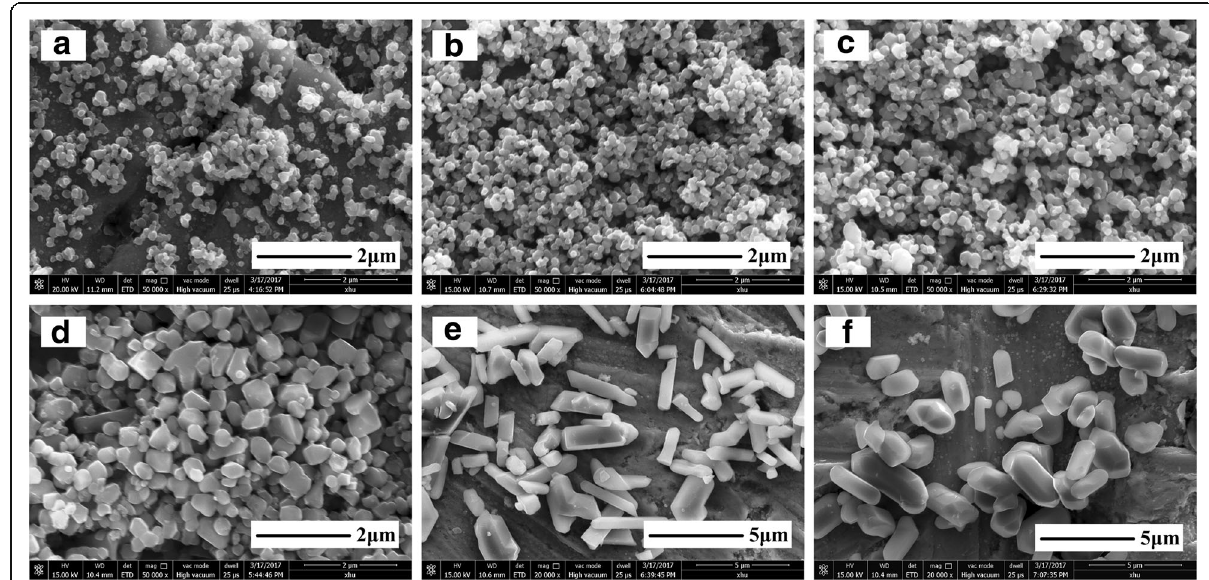
Fig. 2 SEM photographs of undoped TiO 2 and Ti 1 − x Cr x O 2 powders: a undoped TiO 2 , 800 °C; b x =0.00625, 800 °C; c x =0.0375, 800 °C; d undoped TiO